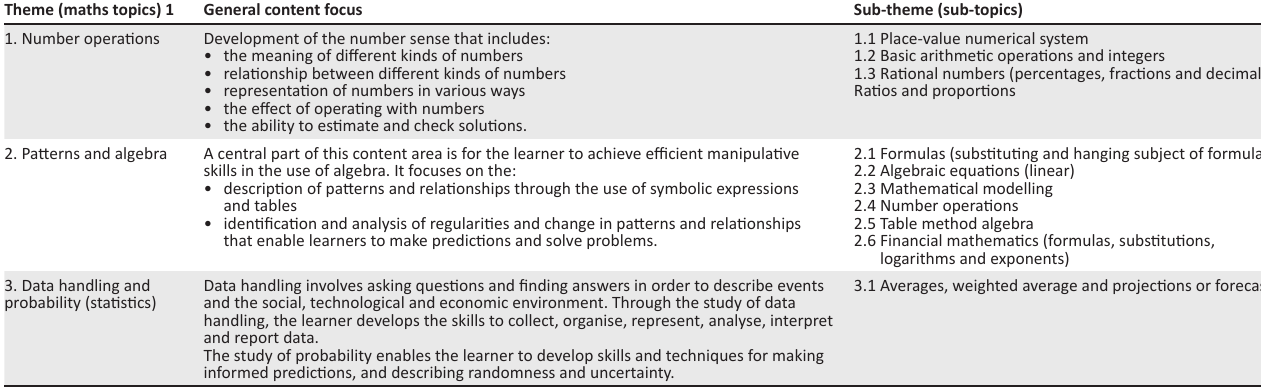
TABLE 3: Themes and sub-themes from content analysis of transdisciplinary relationship between mathematics and accounting.